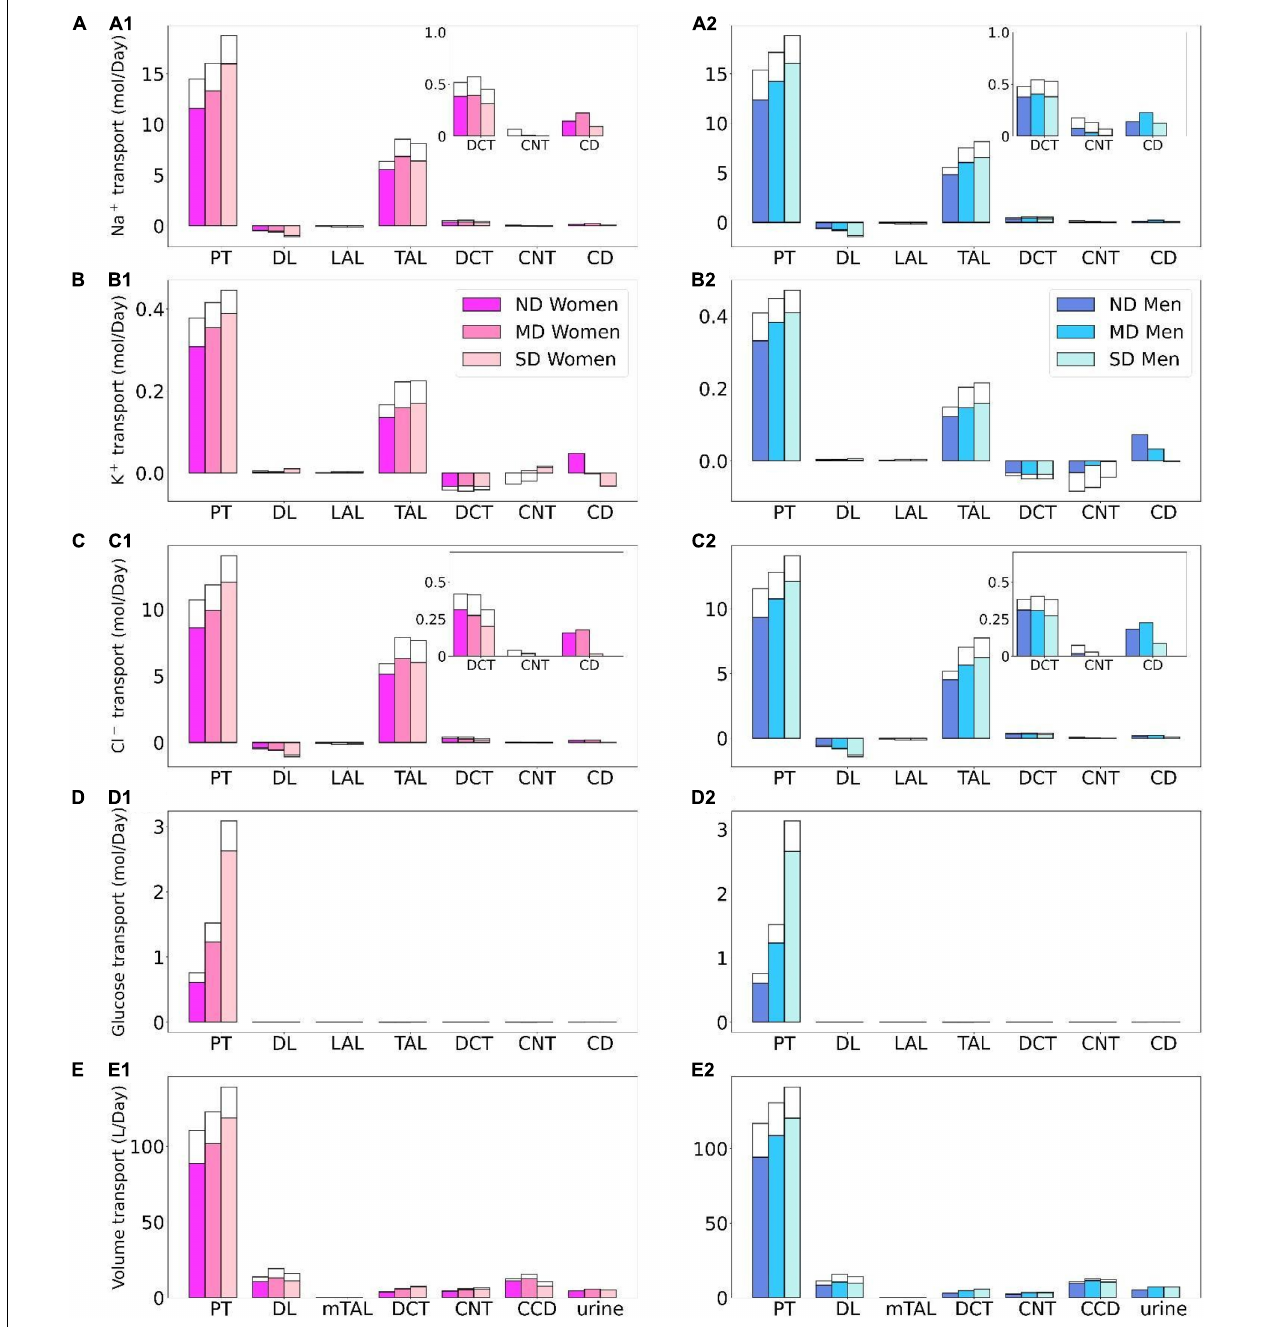
FIGURE 3 | Transport of Na + (A) , K + (B) , Cl – (C) , glucose (D) , and fluid (E) along individual nephron segments in women and men without ND, with MD, and with SD. Notations are analogous to Figure 2 . PT, proximal convoluted tubule and